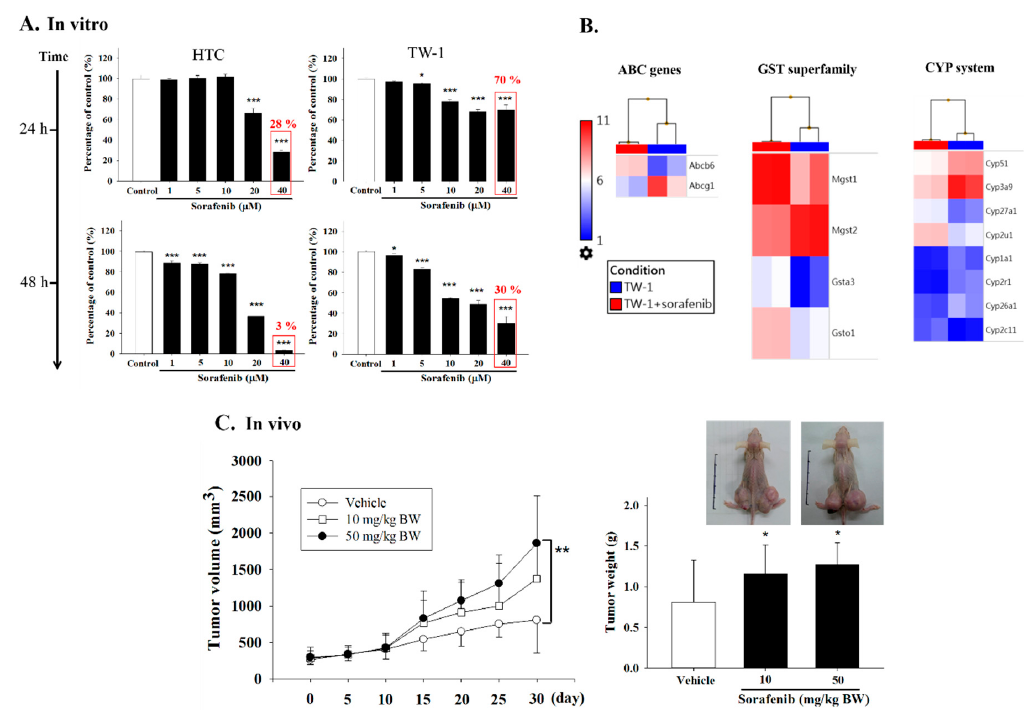
Figure 4. Sorafenib-induced drug resistance in HTC and TW-1 cells. ( A ) HTC and TW-1 cell lines were treated with di ff erent concentrations of sorafenib for 24 and 48 h. MTT assay was used to quantify cell viability.( *: p < 0.05; ***: p < 0.001, v.s. control.) ( B ) Microarray data showed the genes induced by sorafenib. ( C ) Null mice were treated with vehicle control or di ff erent concentrations of sorafenib two weeks after the TW-1 transplantation (the scheme was shown in Figure 3). Tumor volume and weight were measured. (*: p < 0.05; **: p < 0.01, v.s.